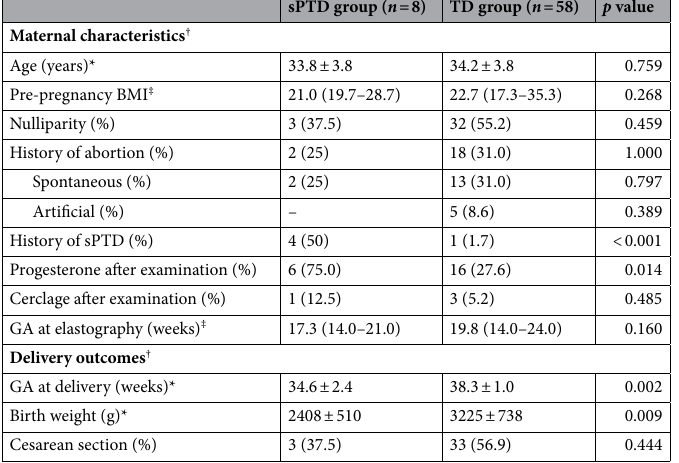
Table 3. Maternal characteristics and delivery outcomes of spontaneous preterm delivery versus term delivery in the LEEP group. † Excludes three cases of iatrogenic preterm delivery; *mean ± standard deviation; ‡ median